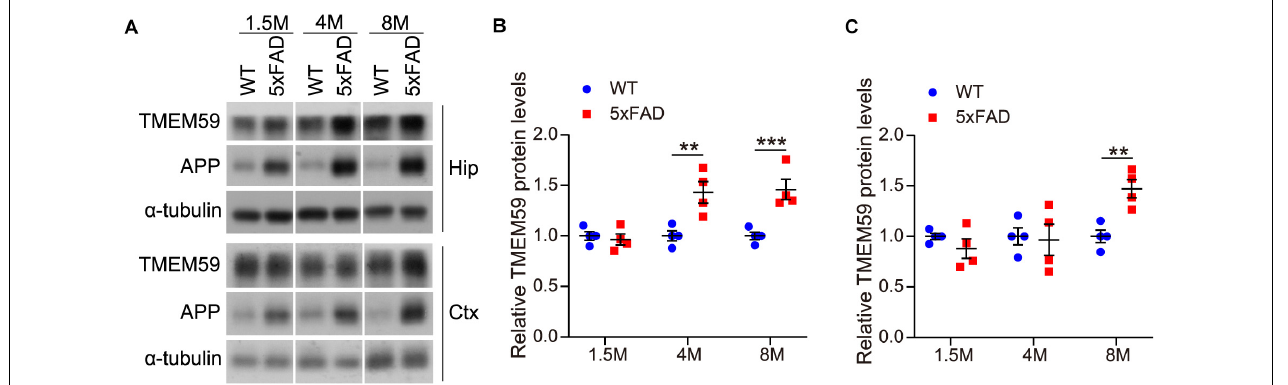
FIGURE 5 | TMEM59 protein levels are increased in 5xFAD mice during aging. (A) Protein lysates of hippocampal (Hip) and cortical (Ctx) tissues from WT and 5xFAD mice at different ages were subjected to western blotting to detect proteins indicated. (B,C) Hippocampal (B) and cortical (C) TMEM59 protein levels in (A) were quantified and compared to respective controls (set to 1.0). Data represent mean ± SEM, n = 4 mice per group. ** p < 0.01, *** p < 0.001. Two-way ANOVA followed by Bonferroni’s post hoc